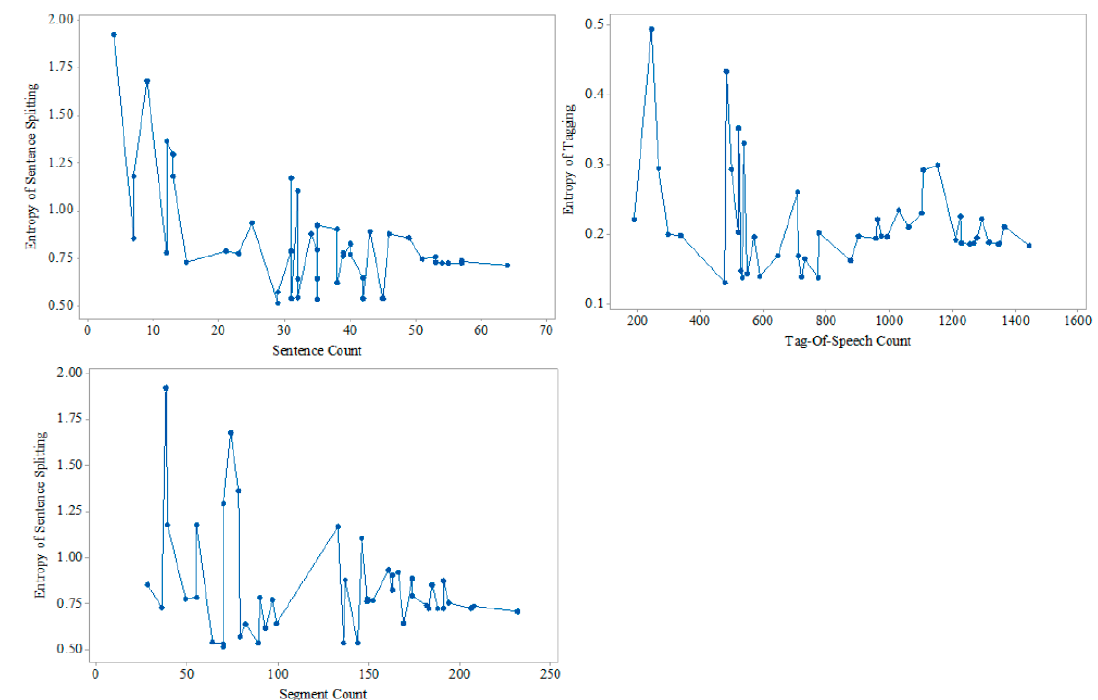
Figure 6. The changes of entropy with the increasing of the number of sentences, the number of part-of-speeches, and the number of segments.